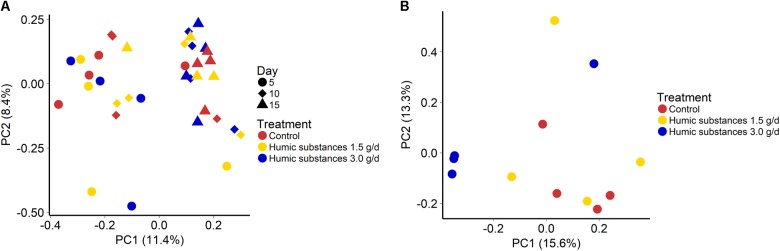
Principal coordinates analysis (PCoA) plots of the Bray–Curtis dissimilarities for (A) solid-associated microbe (SAM) samples by treatment (PERMANOVA: P = 0.43) and sampling time (R2 = 0.11; P < 0.0001) and (B) liquid-associated microbe (LAM) samples by treatment (P = 0.12) at day 15. Percentages of variation explained by the principal coordinates are indicated on the axes.